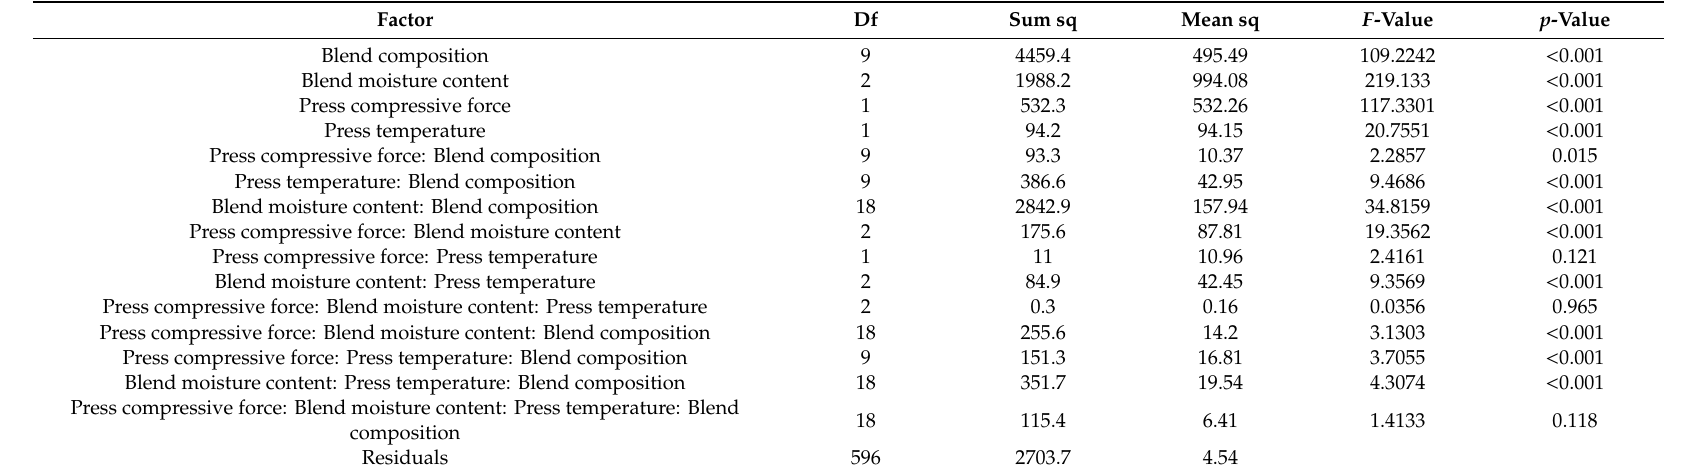
Table 3. Parameters and p -values from ANOVAs testing the e ff ects of blend composition, moisture content, press compressive force, and temperature on pellet friction. Df = Degrees of freedom. Sum sq = Sum of squares. Mean sq = Mean